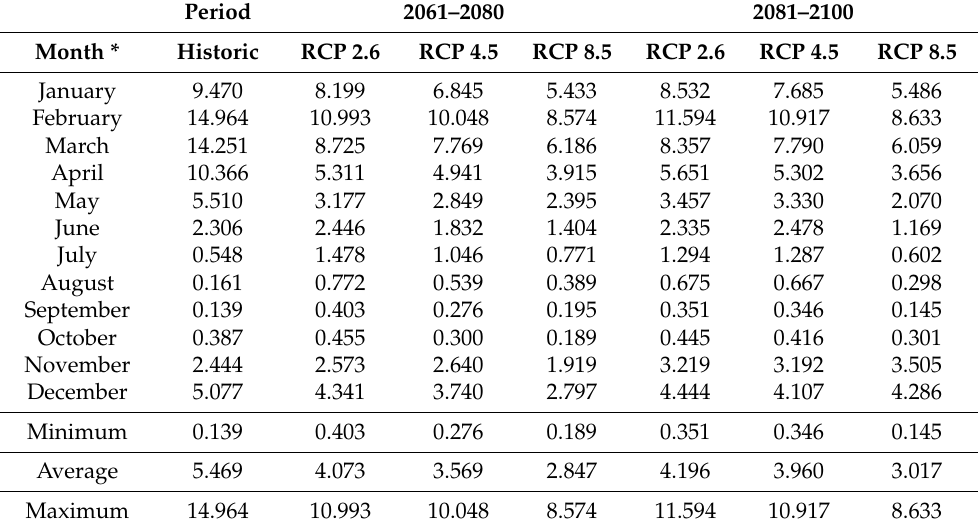
Table 10. Average monthly observed flows (in m 3 /s) of El Kalb river during the historical period and average future simulated flows during the periods 2061–2080 and 2081–2100 and under RCP 2.6, RCP 4.5, and RCP